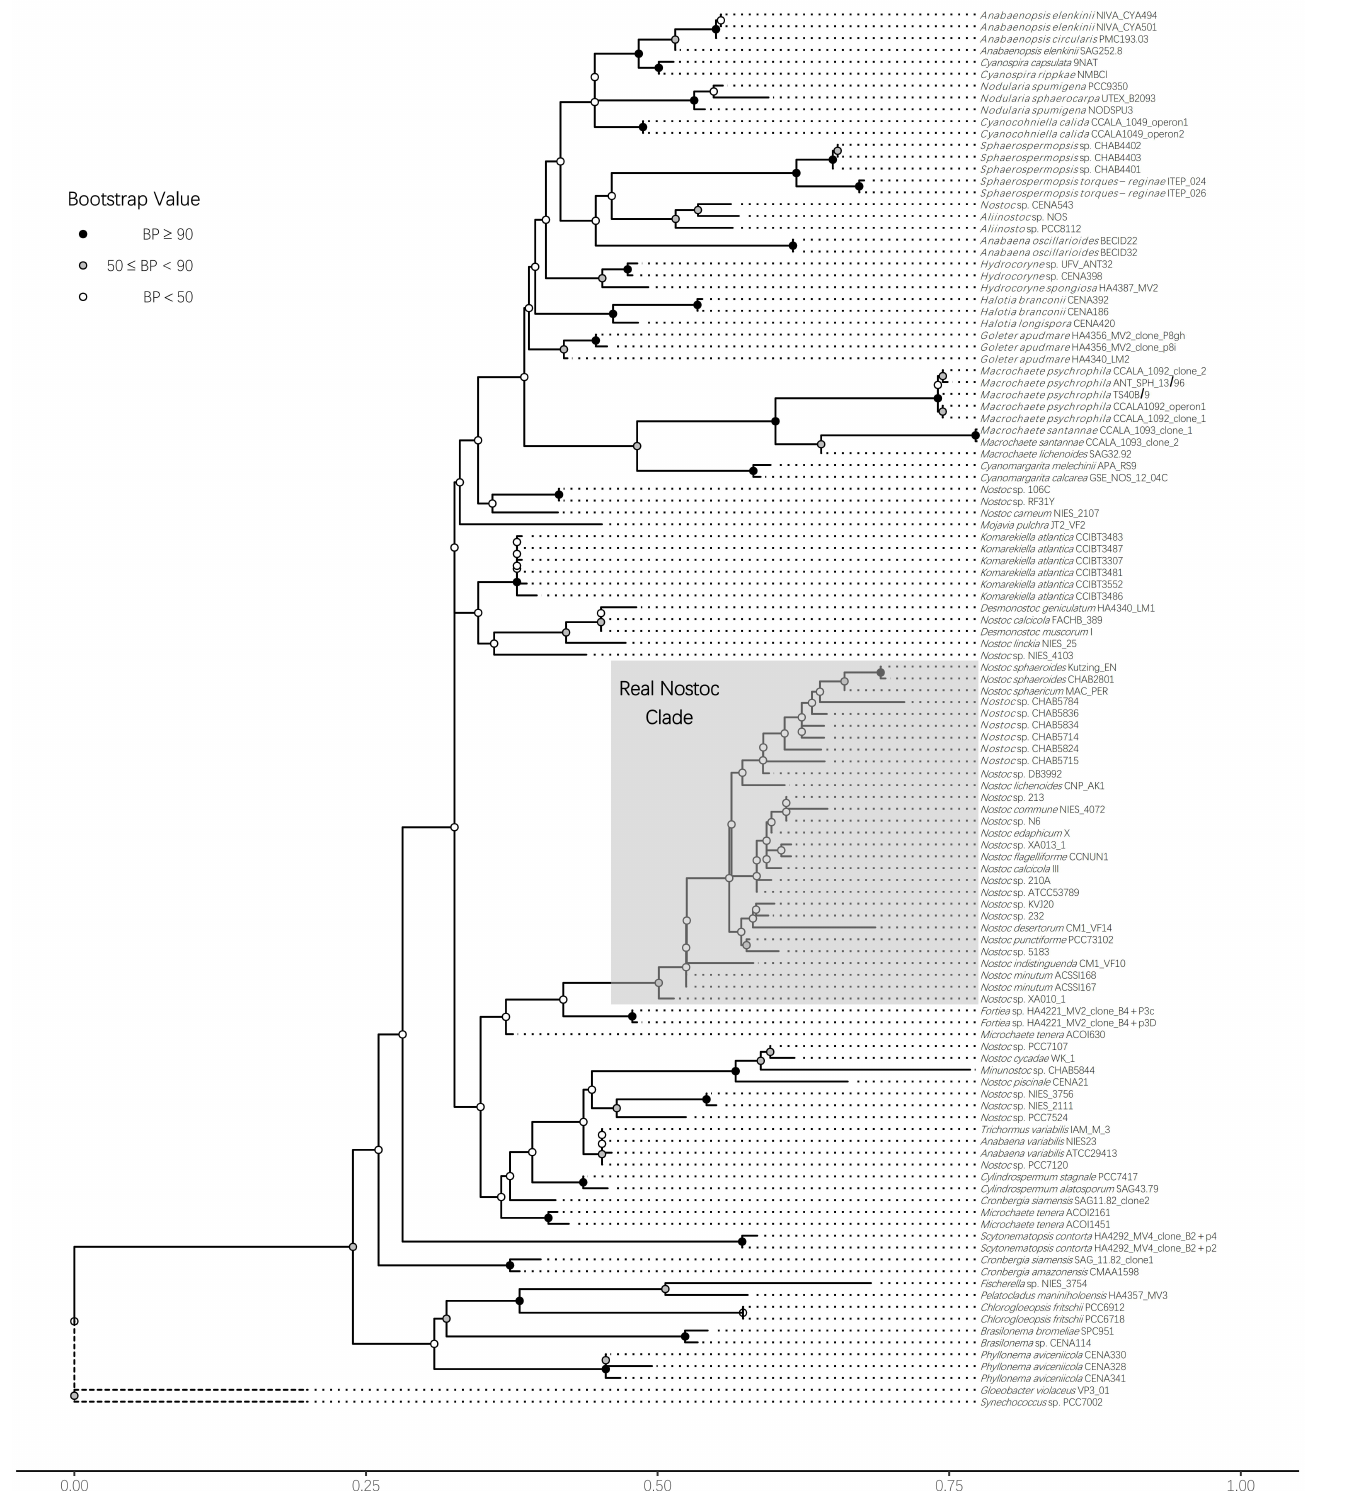
Figure 2. Coordinates of RNS in Nostocales. A maximum-likelihood phylogenetic tree of Nostoc -like strains based on the 16S rRNA gene was constructed, and the topological structure was tested with 1000 replicated bootstrap tests in Raxml. The RNS is marked in the gray shade, and the bootstrap value is shown on each node of the tree.